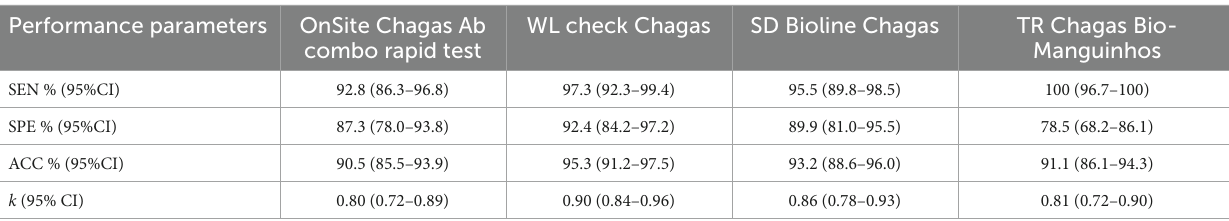
TABLE 1 Diagnostic performance and strength of agreement of four rapid diagnostic tests for the detection of Trypanosoma cruzi IgG. Performance